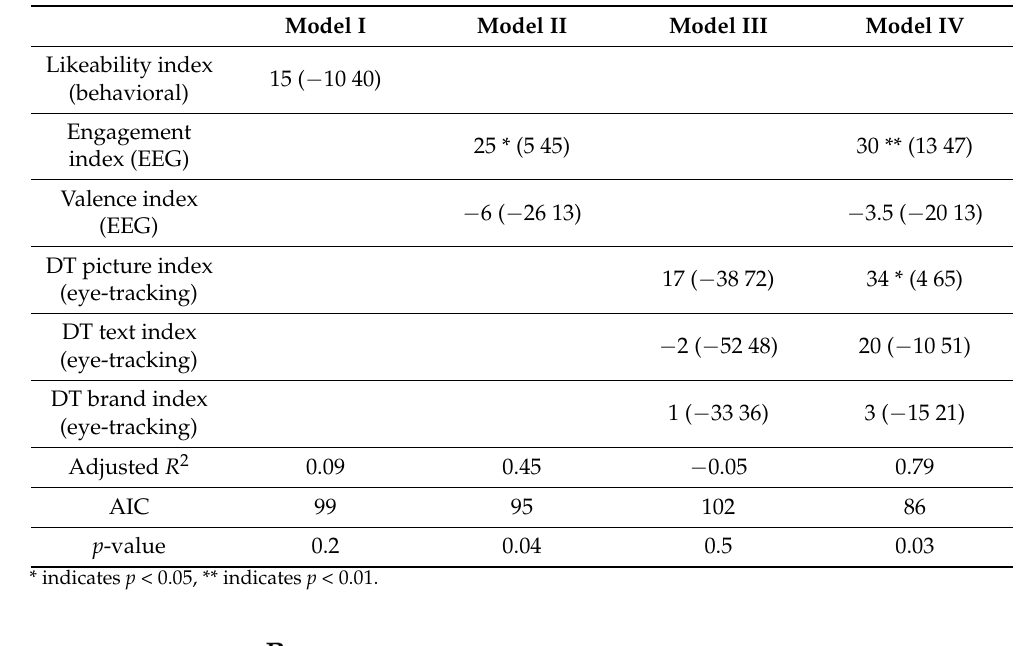
Table 1. Results of the linear regression models predicting population effects of banner ads—session duration index—using behavioral, electroencephalography (EEG), and eye-tracking data (Dwell Time Indexes, DTI). Confidence interval values are presented in the square brackets.